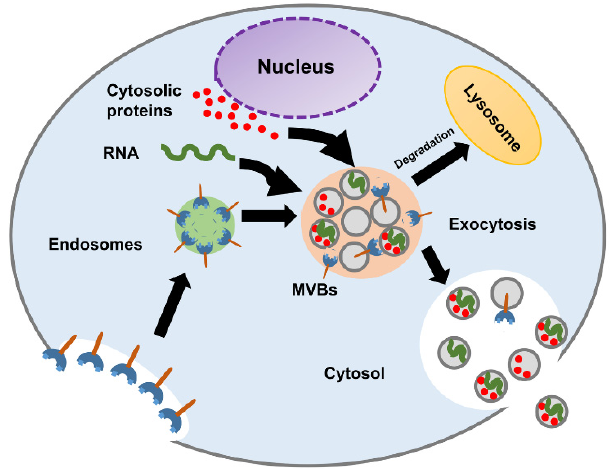
Figure 2. Schematic diagram of exosome biogenesis and molecular composition.